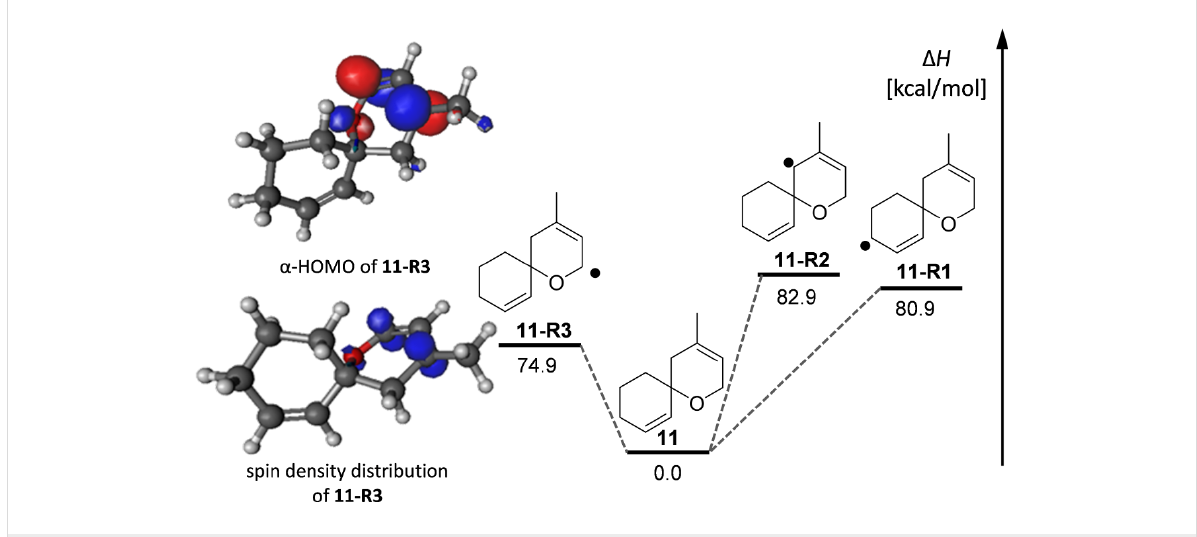
Figure 3: Bond-dissociation enthalpies for three allylic C–H bonds in 11 . Double stabilization of the radical in 11-R3 by the adjacent oxygen and hyperconjugation lead to a rather low BDH of 74.9 kcal/mol (B3LYP/6-31+G**).